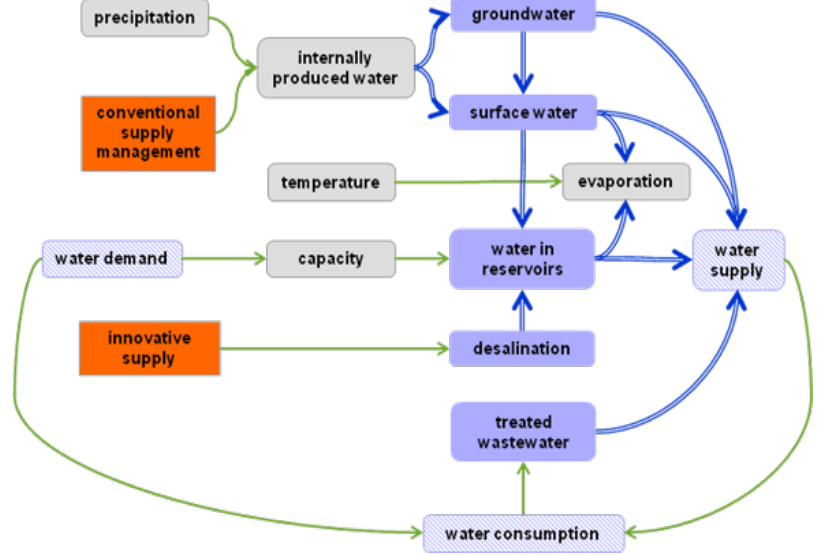
Figure 1. Sources of water supply (in blue boxes) and key influencing factors (in grey). Investment options in water supply management (conventional and innovative) are highlighted in orange. The water flows between various sources are presented in thick blue arrows, while green ones indicate impacts of key factors on water